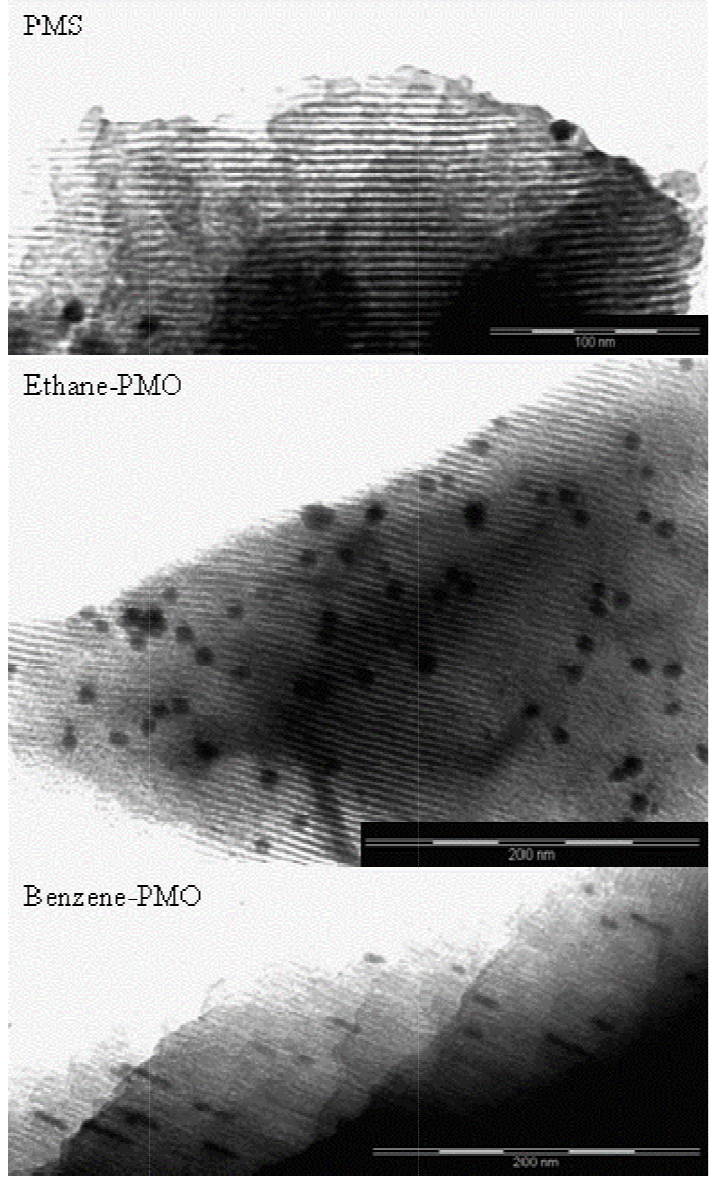
deter m mined by hy Sup P Ethan Benze